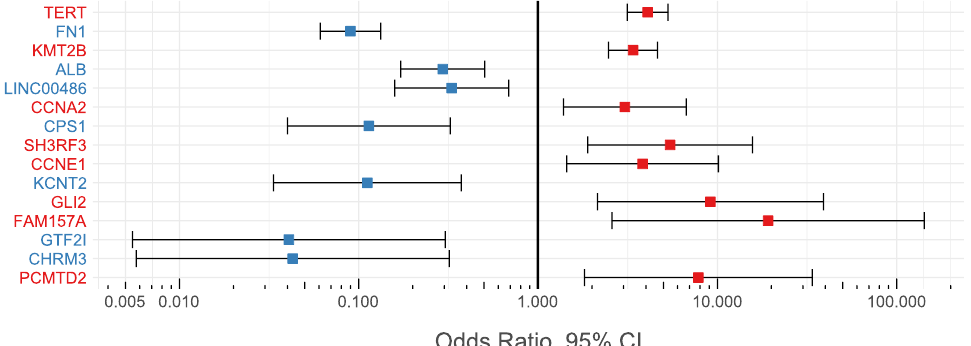
Figure 3. Odds ratios (OR) and 95% confidence intervals (95% CI) obtained by comparing the HBV integrations between the HCC and non-tumor groups in 15 human genes, represented as a log 10 -scaled